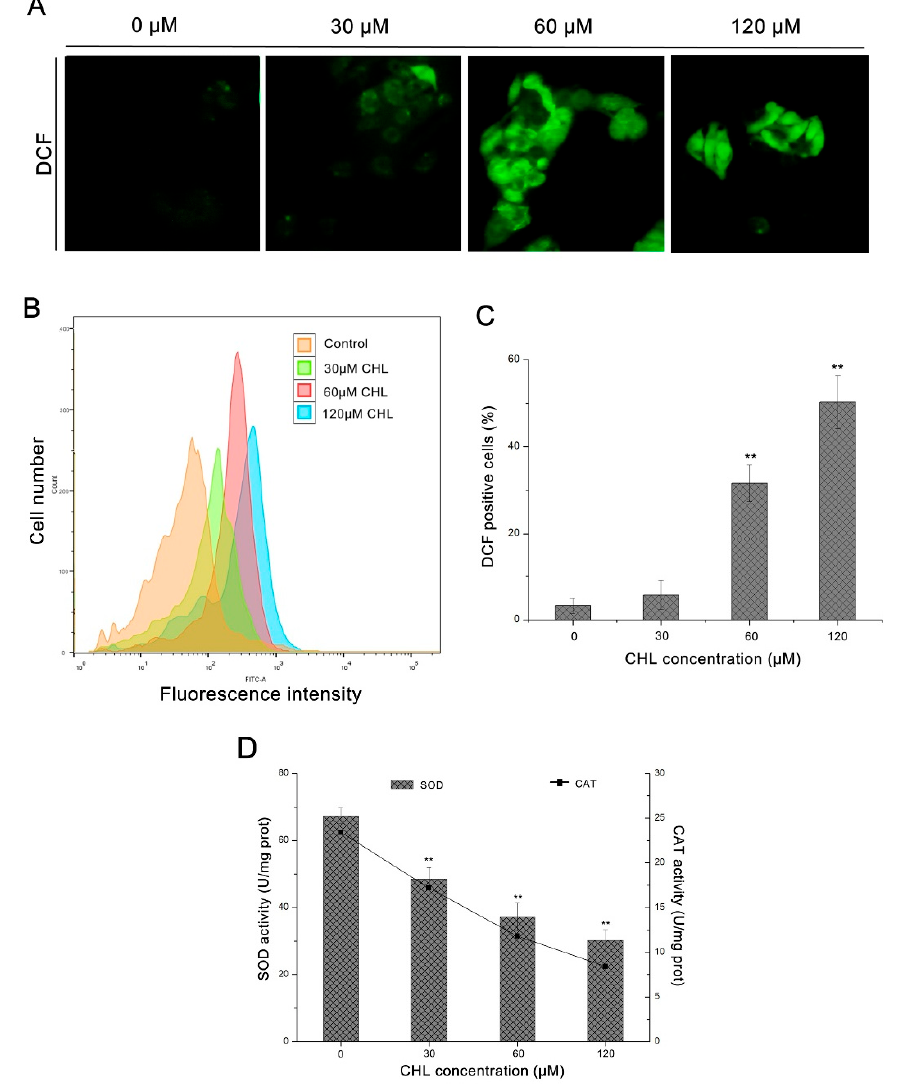
Figure 2. Analysis of ROS production and antioxidant enzyme activity in HepG2 cells after treatment with CHL. ( A ): Analysis of DCF staining by epifluorescence (200×). ( B ): Analysis of DCF staining by flow cytometry. ( C ): Quantification of ROS levels. ( D ): Activity of SOD and CAT enzymes. ** p ≤ 0.01 vs. the negative control.